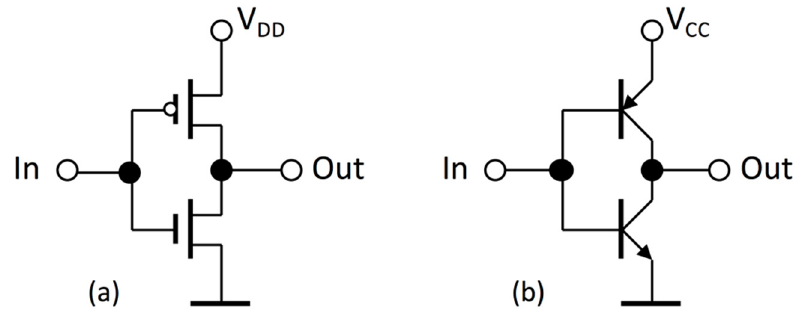
Figure 1. Simplest logic gates: ( a ) inverter CMOS; ( b ) bipolar inverter